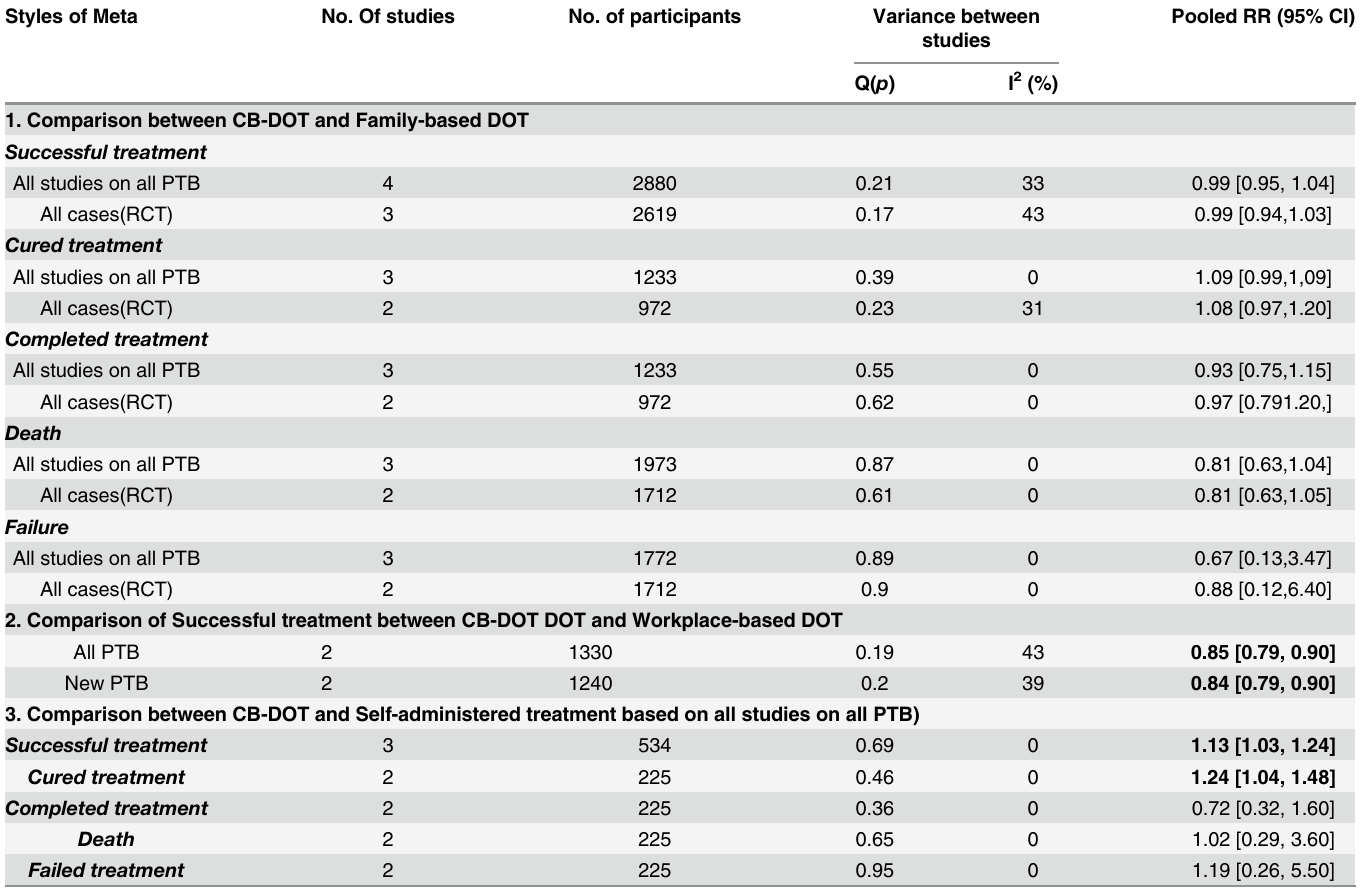
Table 3. Results of meta-analysis of the studies on comparison between CB-DOT and Family-based DOT, Workplace-based DOT and administered treatment in TB control. Styles of